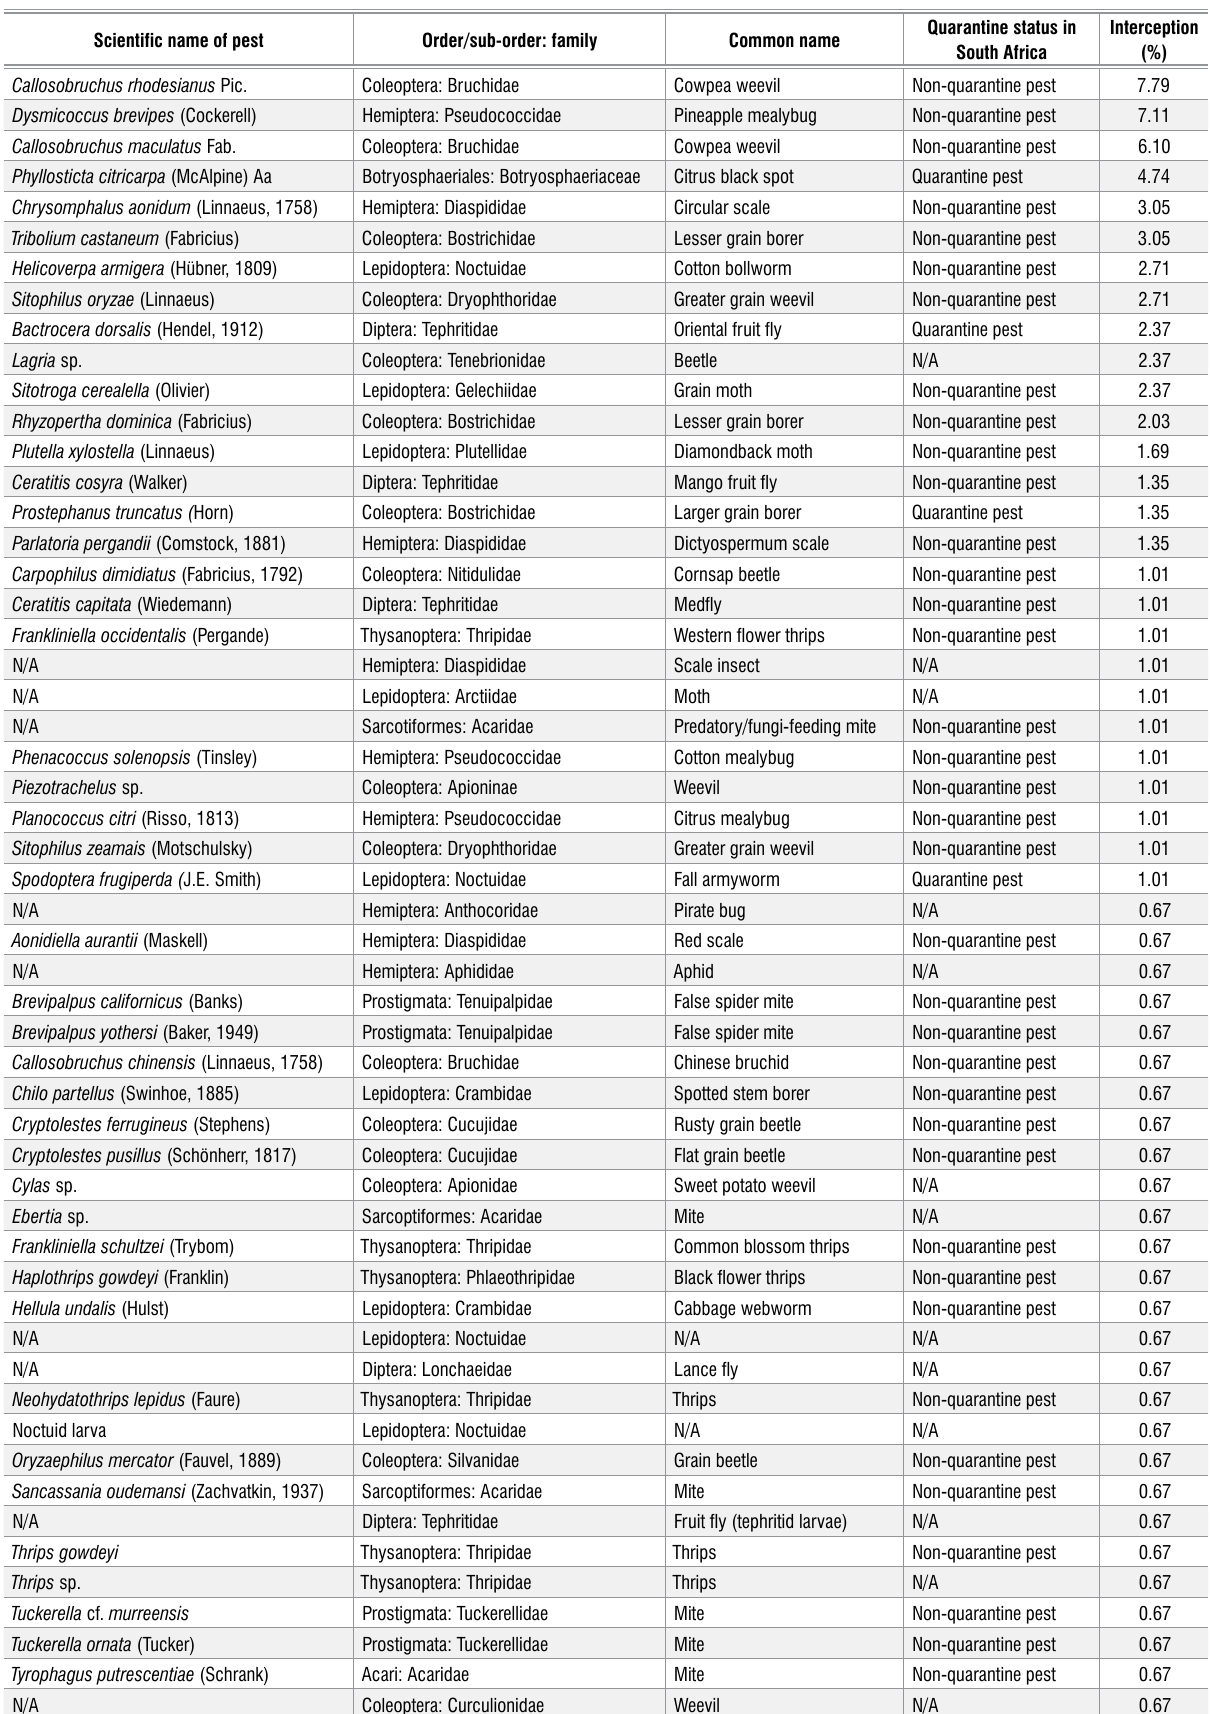
Table 2: Identity and quarantine status of intercepted organisms into South Africa, 2011–2019 ( n